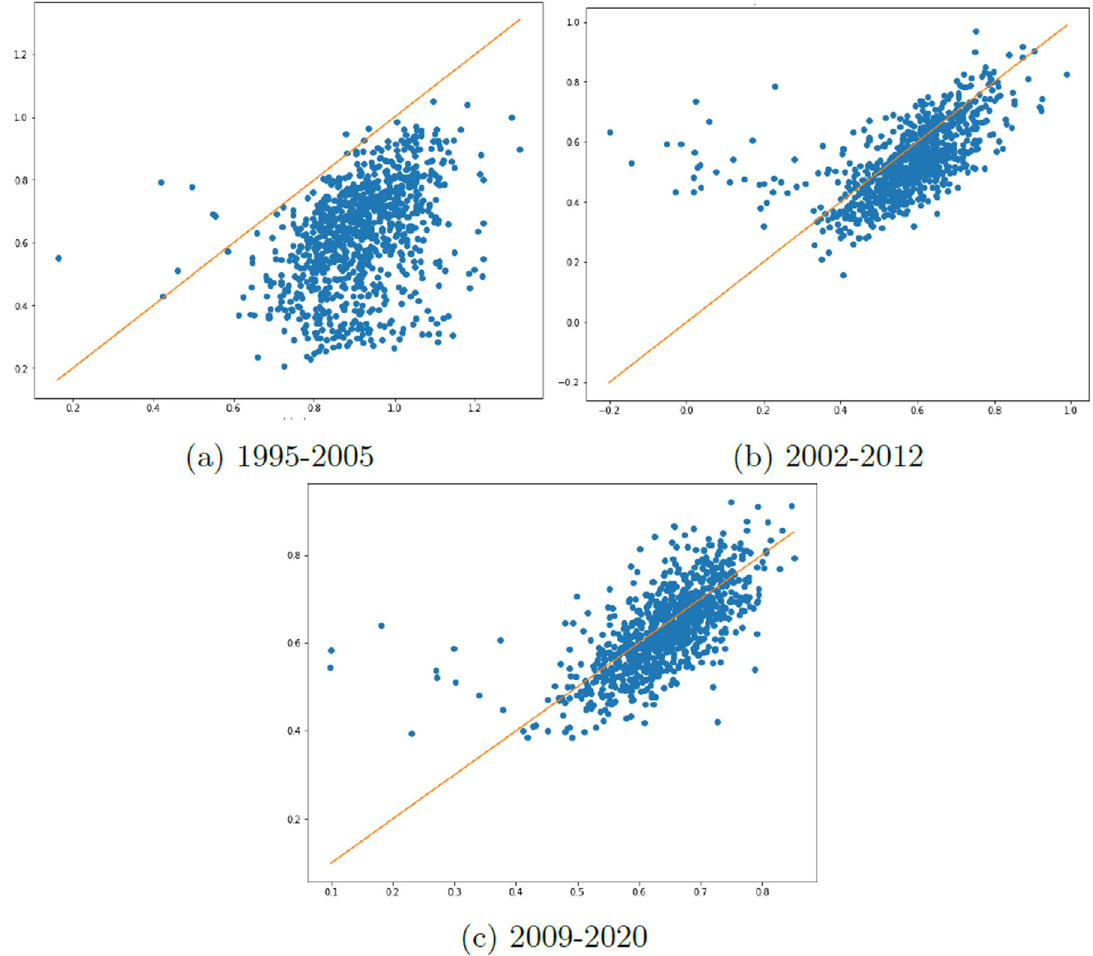
Fig. 5 Sharpe ratio for 10-year samples. The fi rst coordinate is the constrained portfolio, while the second coordinate is the unconstrained